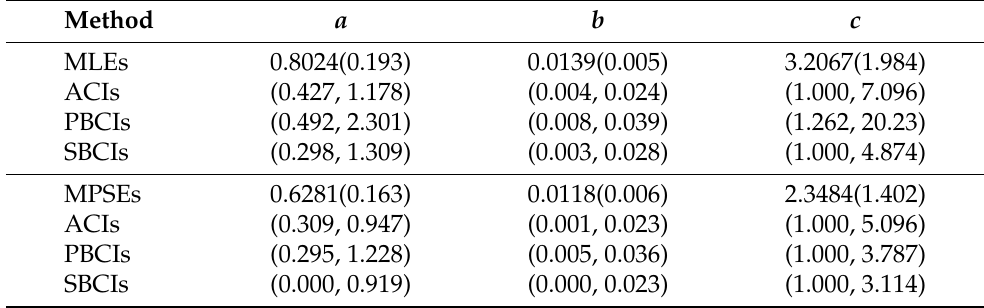
Figure 11. The empirical and fitted CDF of the MKE distribution for oil breakdown data. Table 6. The MLEs, MPSEs and the corresponding standard errors (in parentheses) and the different 95% CIs for the oil breakdown Type-II censored CSPALT data.